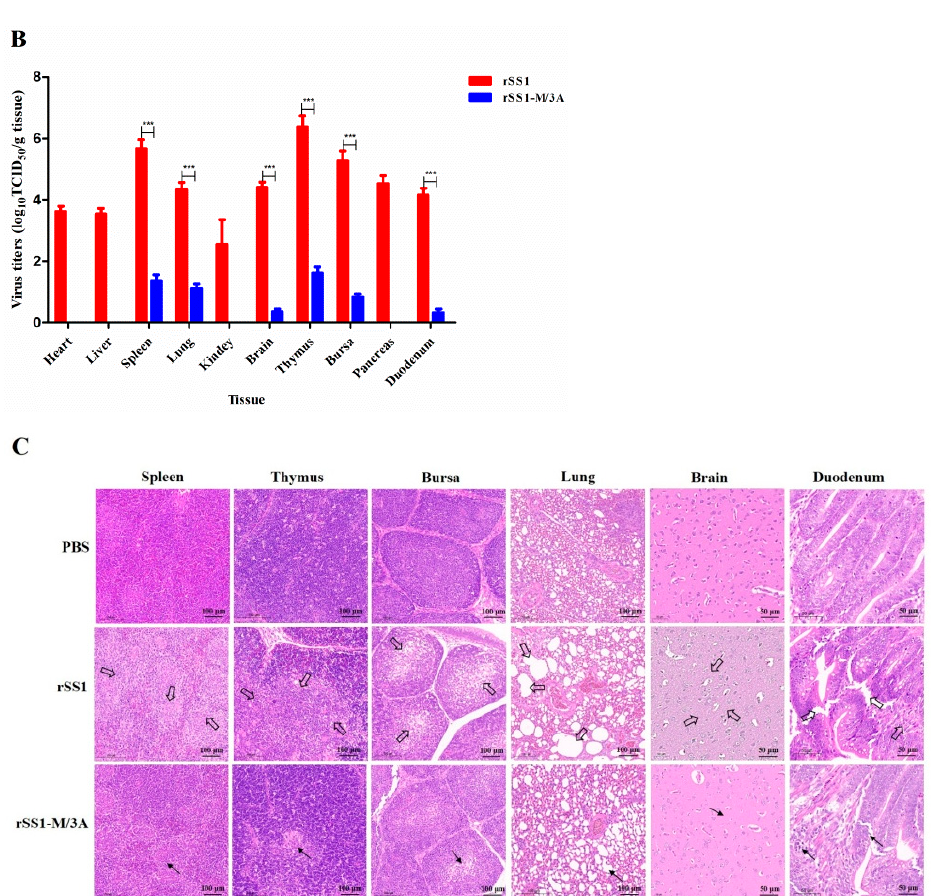
Figure 6. The M/3A protein attenuates the pathogenicity of recombinant NDV in SPF chickens. ( A ) Survival curves of 4-week-old SPF chickens inoculated with PBS, rSS1, or rSS1-M/3A. ( B ) Viral load in the collected tissues of 4-week-old chickens infected with the two viruses at 4 dpi. Asterisks denote significant differences (***, p < 0.001). ( C ) Histopathology of the tissue samples collected from rSS1-, rSS1-M/3A-, or PBS-inoculated 4-week-old chickens at 4 dpi. Empty arrow indicates the severe histopathological changes in the tissues of rSS1-infected chickens; black arrow indicates the slight histopathological changes in the tissues of rSS1-M/3A-infected chickens.